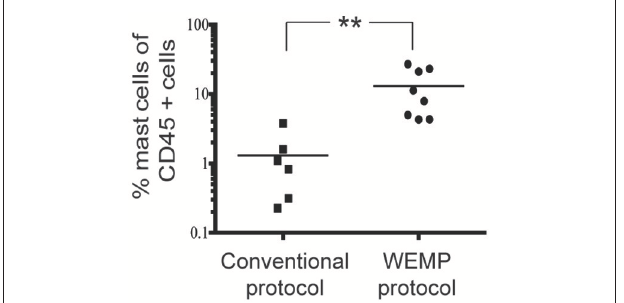
TABLE 1 | RNA sequencing of sorted human lung mast cells.